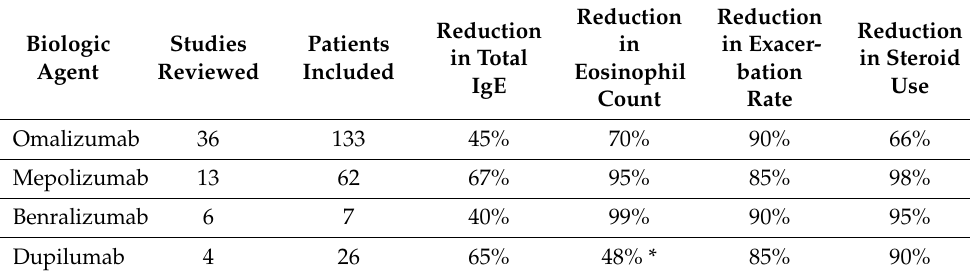
Table 1. Aggregate summarized clinical outcome results of 59 studies with 228 adult patients